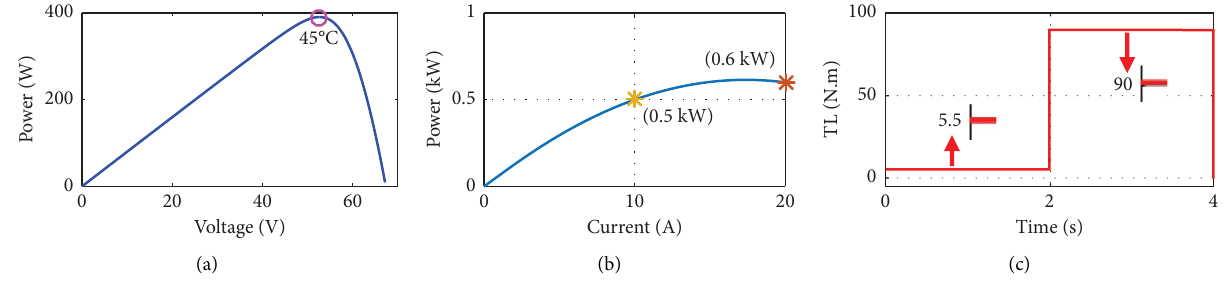
Figure 14: Systems inputs in the frst operation mode. (a) PV characteristic, (b) FC characteristic, and (c) torque.